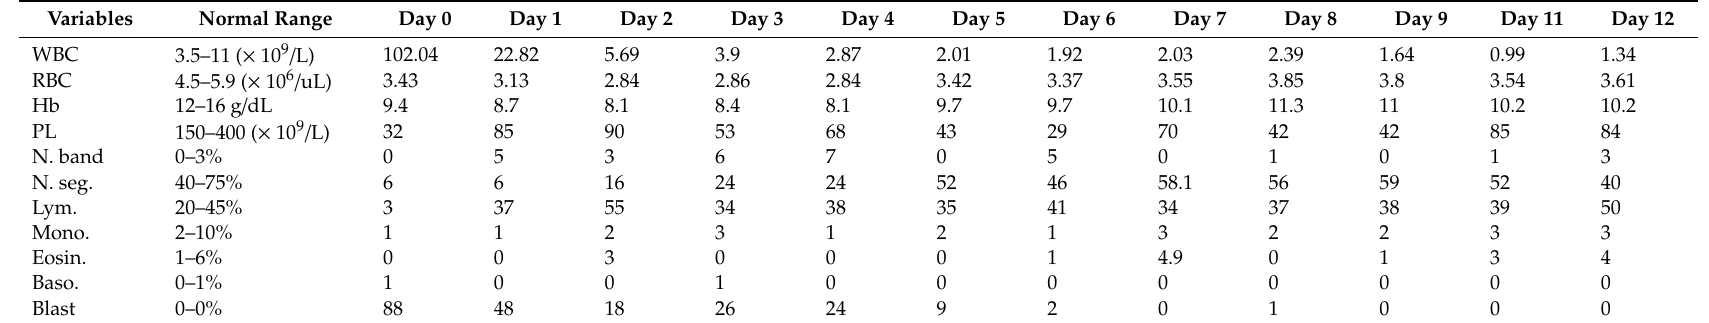
Table 2. The follow-up laboratory data of this